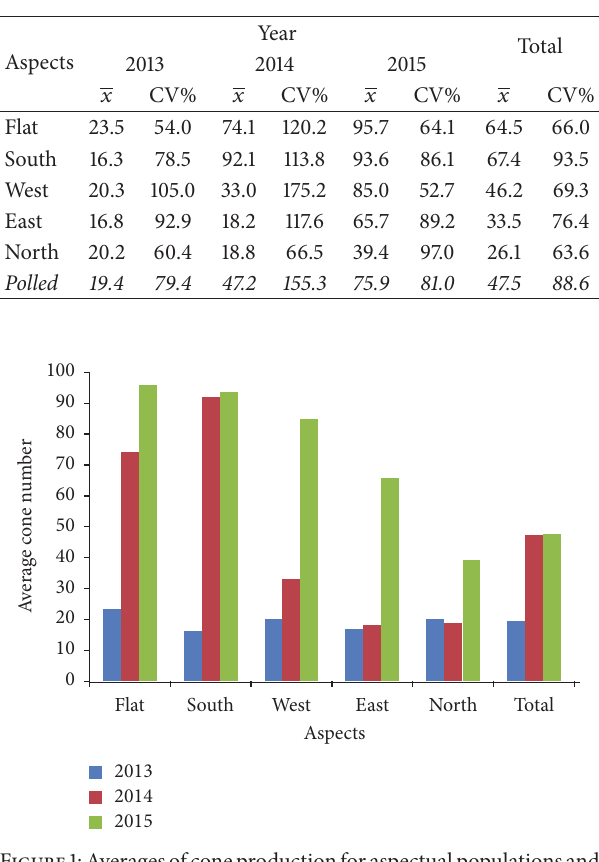
Figure1:Averagesofconeproductionforaspectualpopulationsand